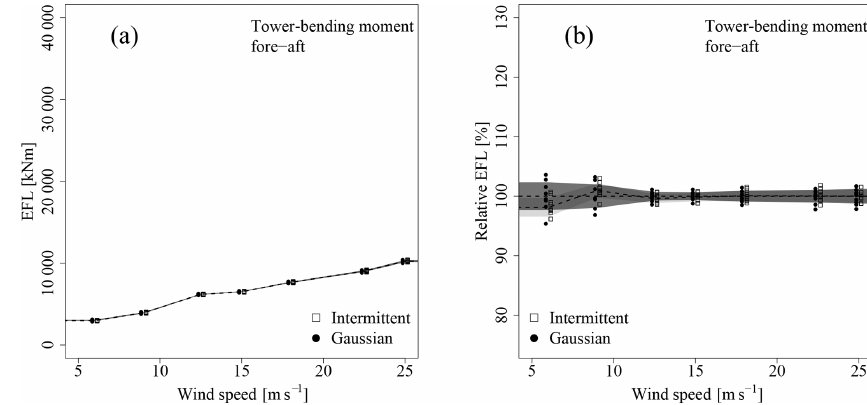
Figure 10. EFL for the TBMFA for the delta-correlated case. The figure is analogous to Fig. 7.